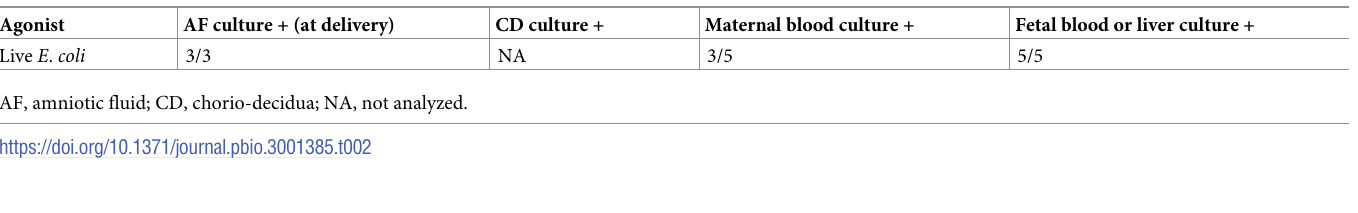
Table 2. E . coli invasion in tissue